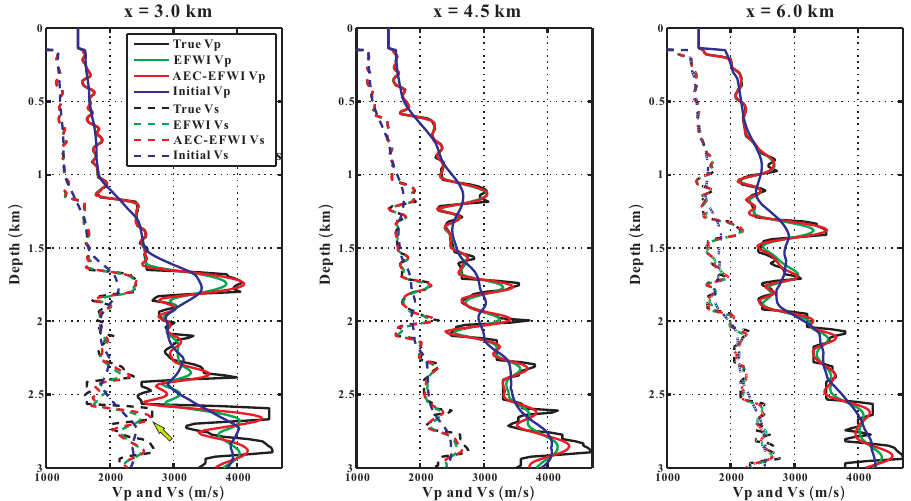
Figure 14. Vertical profiles of Vp (solid) and Vs (dashed) at the horizontal distances of 3.0, 4.5, and 6 km.